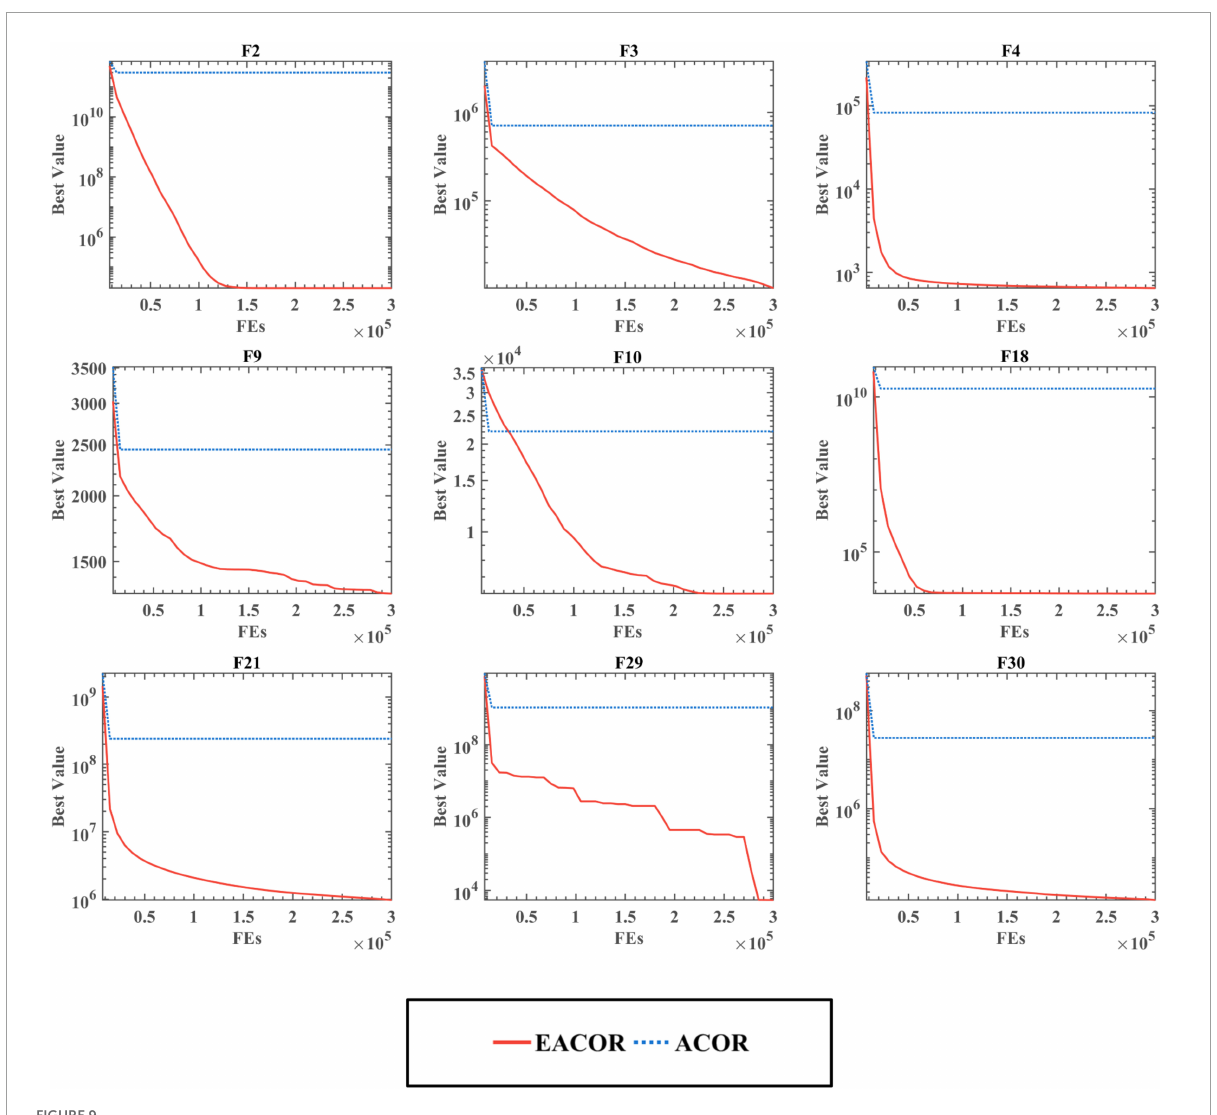
FIGURE9 Convergence curves of EACOR and ACOR at 100